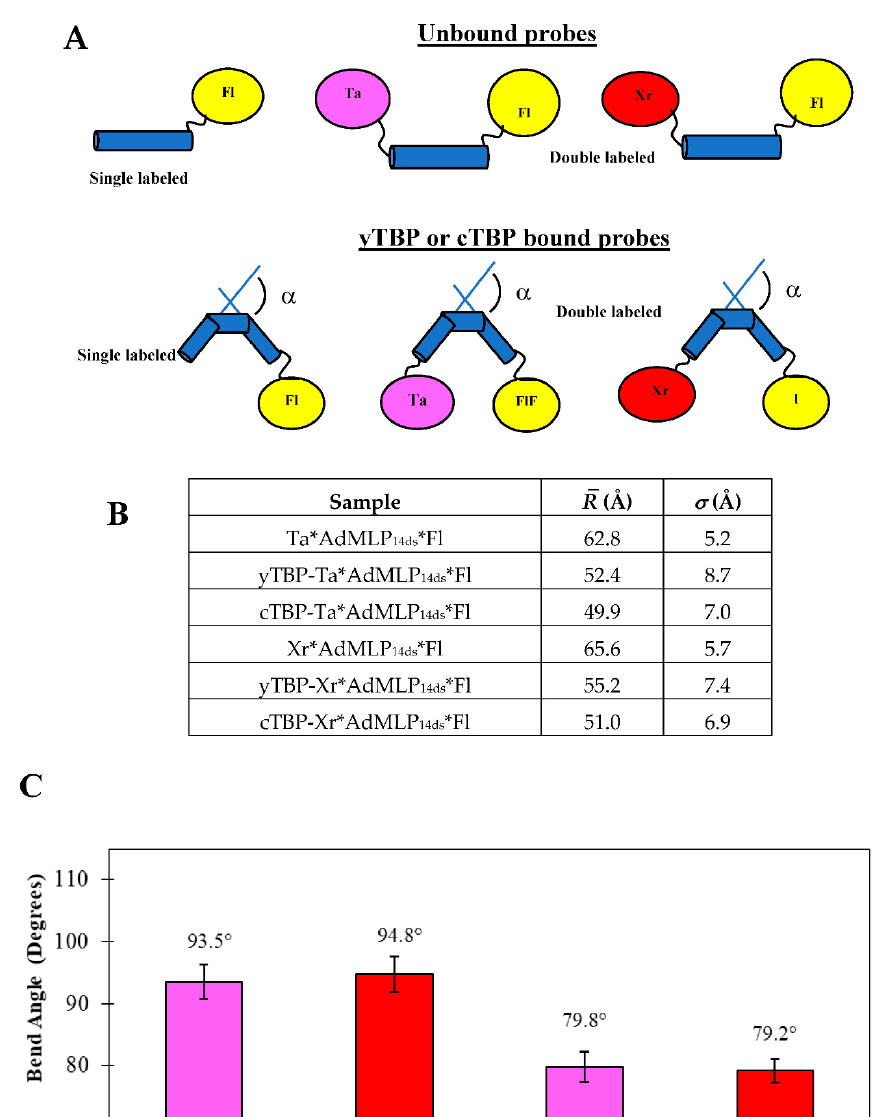
Figure 9. The interdye distances and bend angles of free AdMLP 14ds probes and bound to cTBP and yTBP, at 20 °C. ( A ) To calculate the P(R) distance distribution, it is required to obtain the lifetime of the single and double-labeled probe as free and bound complexes with TBP proteins. The Ta*AdMLP 14ds *Fl probes were straight but after complex formation with yTBP or cTBP, the DNA is bent, which shortens the interdye R resulting in more energy transfer from Fl donor toward the acceptor (Ta or Xr). ( B ) The P(R) distance distribution is described by the mean distance R and the spread σ of the unbound probes and the respective complexes formed with yTBP and cTBP. ( C ) The bend angle ( α ) of the TATA distortion for the canonical AdMLP is calculated according to Equation (25), requiring the R -value and where L2 was 20.4 Å. The bend angle produced by each protein was independent of the probe used since the values overlapped in error for the Xr*AdMLP 14ds *Fl and Ta*AdML P14ds *Fl complexes formed with yTBP and cTBP, respectively. The bend angles caused by cTBP for both probes were larger than those observed by yTBP since the latter has an N-terminal domain that regulated the binding and shifts the equilibrium to the left, or towards the reactants